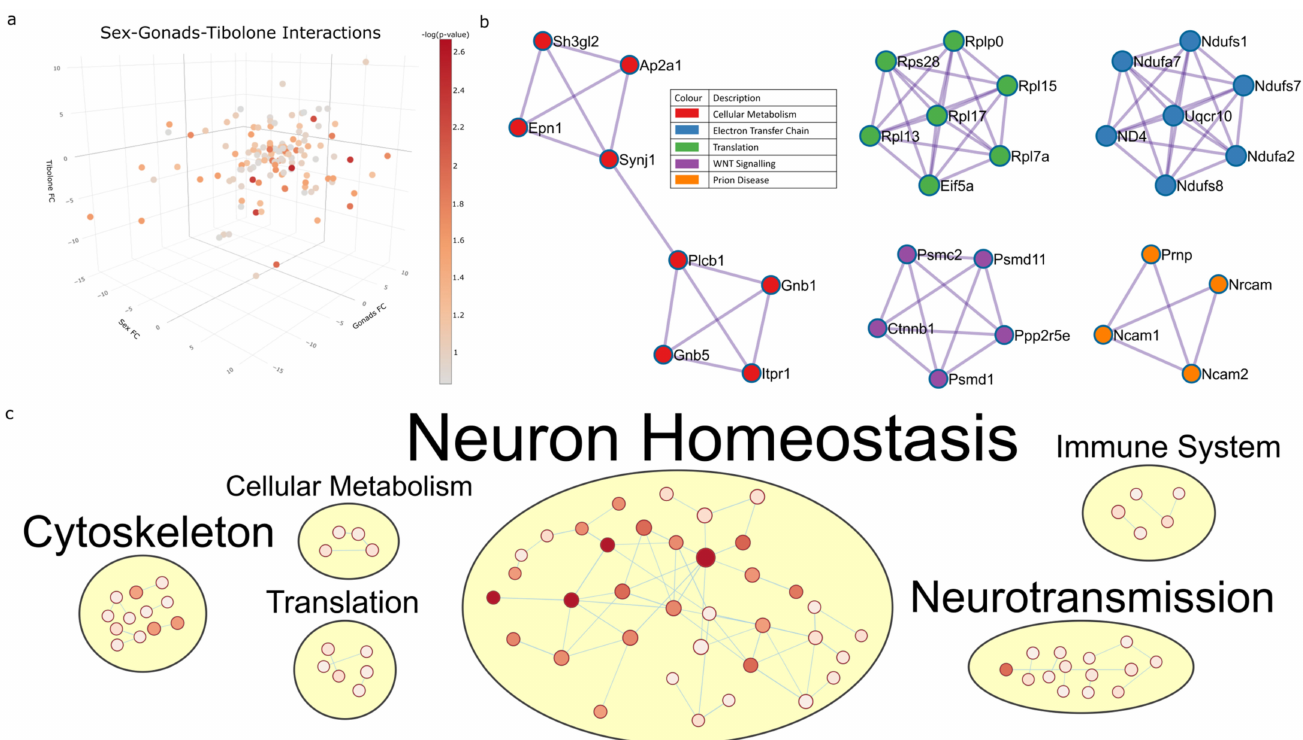
Figure 7. Three-way interaction of proteins regulated by sex, gonads and Tibolone. A total of 139 pro- teins were identified to be regulated by sex–gonad–Tibolone interactions ( a ). PPI analysis of these proteins ( b ) identified respiratory electron transport (blue, p = 3.16 × 10 − 17 ) to be the most significant function and MCODE node cluster. This was followed by cytoplasmic ribosomal proteins (green, p = 6.3 × 10 − 14 ), the degradation of beta-catenin by the destruction complex (purple, p = 6.3 × 10 − 13 ), the regulation of insulin (red, p = 3.98 × 10 − 9 ) and prion diseases (orange, p = 1.58 × 10 − 8 ). When PPI analysis was performed on all proteins as a single cluster, Alzheimer’s disease was the most significant function ( p = 2.5 × 10 − 10 ). Enriched functions were mapped into related groups ( c ) in which the most significant functions regulated by sex–gonad–Tibolone interactions per category were the synapse ( q = 1.52 × 10 − 34 ) in GO cellular components, transport ( q = 4.68 × 10 − 8 ) in the GO biological process, Alzheimer’s disease and retrograde endocannabinoid signalling ( q = 5.77 × 10 − 8 ) in KEGG pathways, metabolism ( q = 2.18 × 10 − 5 ) in reactome pathways and structural molecule activity ( q = 7.51 × 10 − 5 ) in GO molecular